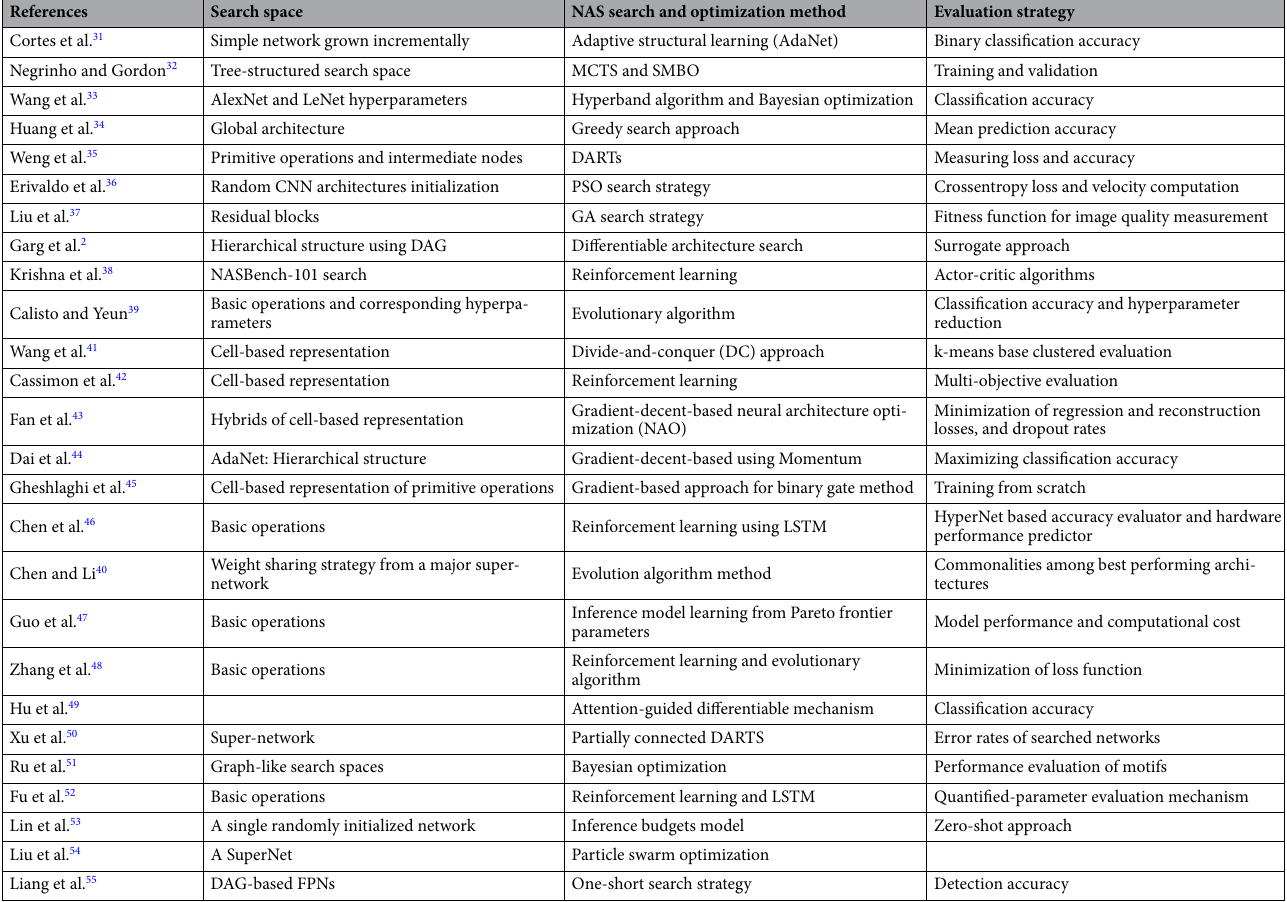
Table 2. Summary of the reviewed